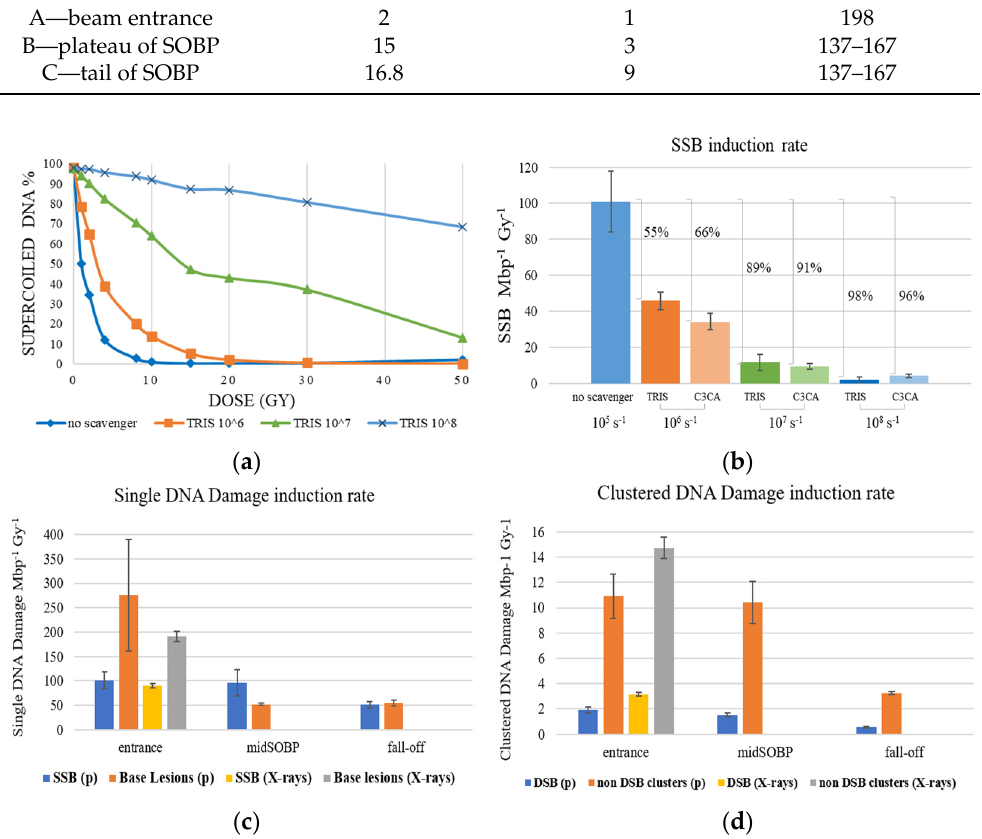
Figure 2. Proton (p) and X-rays − induced DNA damage. ( a ) Proton (entrance) − induced damage revealed as the decrease of SC plasmid with dose for Tris scavenging capacity ranging from no scavenging (10 5 s − 1 of residual Tris) to 10 8 s − 1 , revealing the radioprotectant shielding of the plasmid integrity (up to 90%) the highest Tris concentration. ( b ) SSB Mbp − 1 Gy − 1 versus scavenging capacity for Tris and C3CA for 198 MeV protons at the entrance of the beam proves concentration-dependent manner. ( c ) Average number of SSB and single base lesions produced along the Proton Treatment Plan or X-rays, respectively. ( d ) Average number of DSB and non − DSB clustered damage produced along the Proton Treatment Plan or X-rays. The positions are the entrance of the beam, the middle of the SOBP plateau (midSOBP) and SOBP fall-off, as seen in Figure 3 and Table 1.